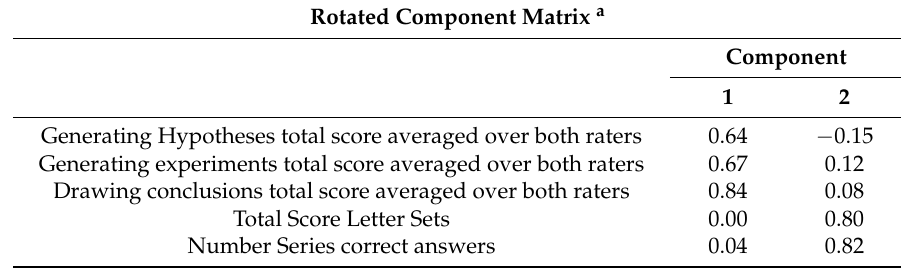
Table 3. Rotated principal component matrix in the Study 1 principal components analysis of the total scores of our subscales and the analytical ability tests.